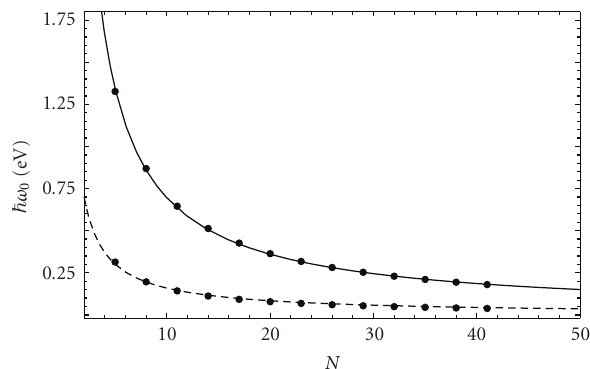
Figure 2: Threshold energy for GNRs as a function of their width. The solid line fits for AGNRs and the dashed line for ZGNRs.